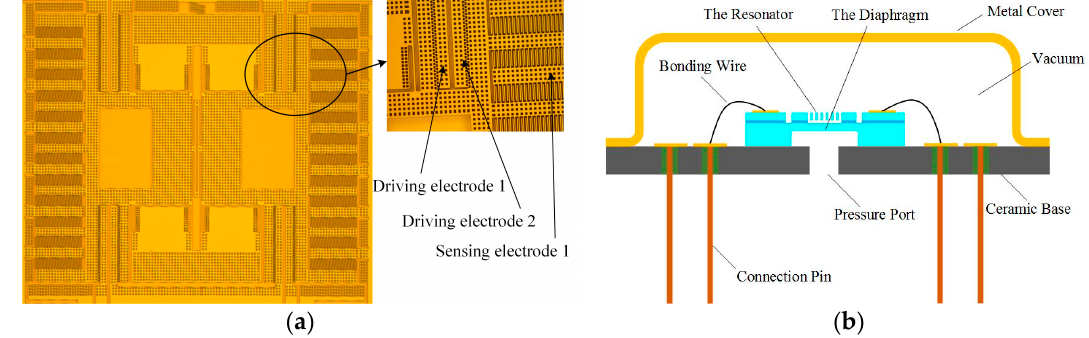
Figure 7. ( a ) The picture of the fabricated resonator; ( b ) The schematic drawing of the sensor package.